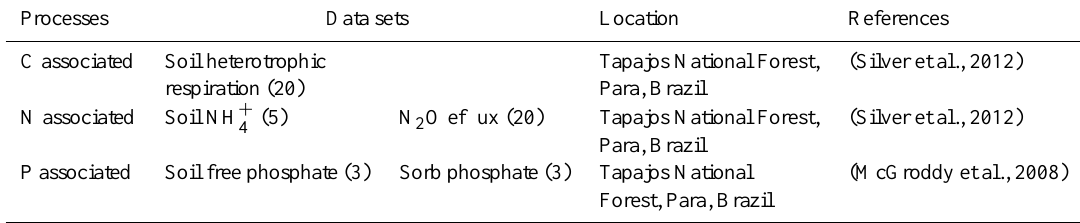
Table 3. Observational data sets used for calibration. Number of observations for each data stream is included in brackets. Processes